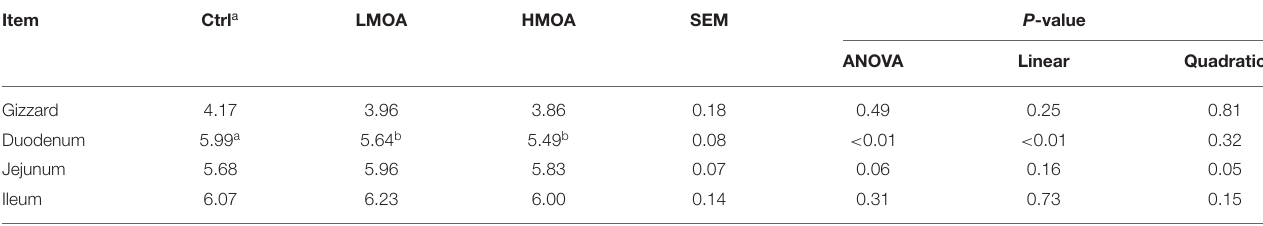
TABLE 5 | The pH value of gut in 42 d-broilers as affected by dietary MOA